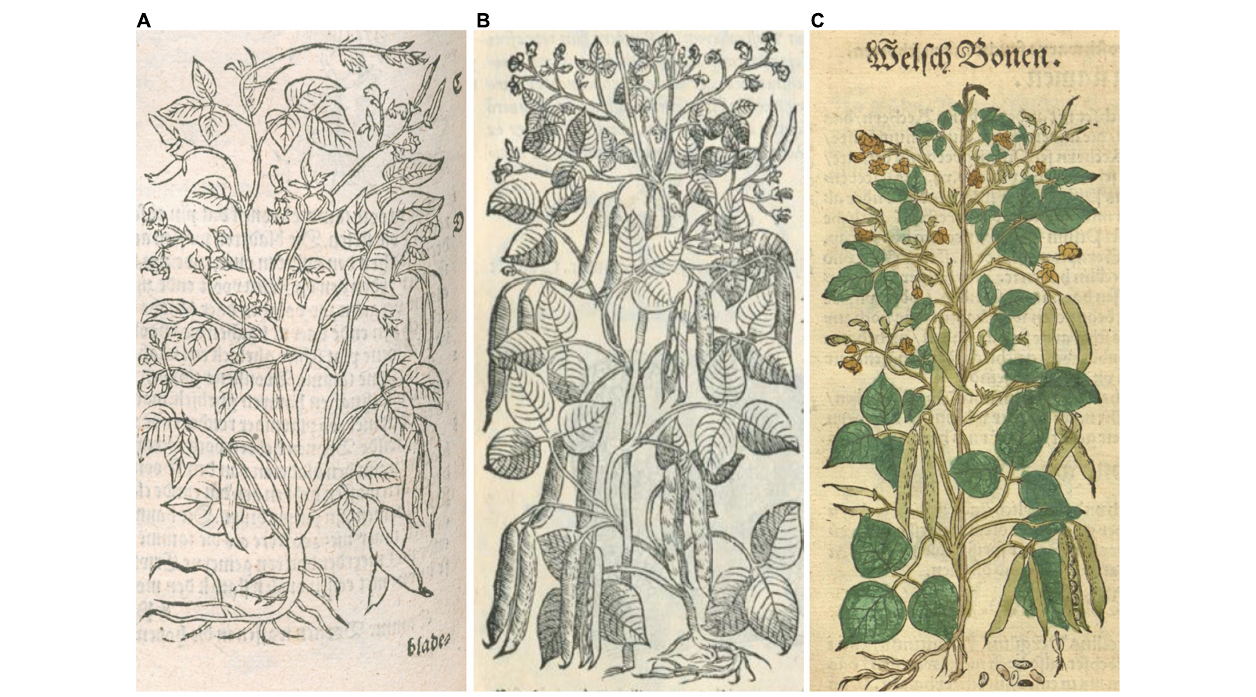
FIGURE 5 | Woodcuts of common beans from 16th-century herbals. (A) Dodoens (1563), Cruÿdeboeck ... Source: Public domain; Wellcome Library, London, United Kingdom (Proquest). (B) Bock (1546), New Kreuterbuch. Source: Public domain; Biodiversity Heritage Library (Holding Institution: Missouri Botanical Garden, St. Louis, MO, United States) . (C) Mattioli (1558), Medici, commentar secondo aucti ... Source: Public domain; Universitats- und Landesbibliothek Dusseldor